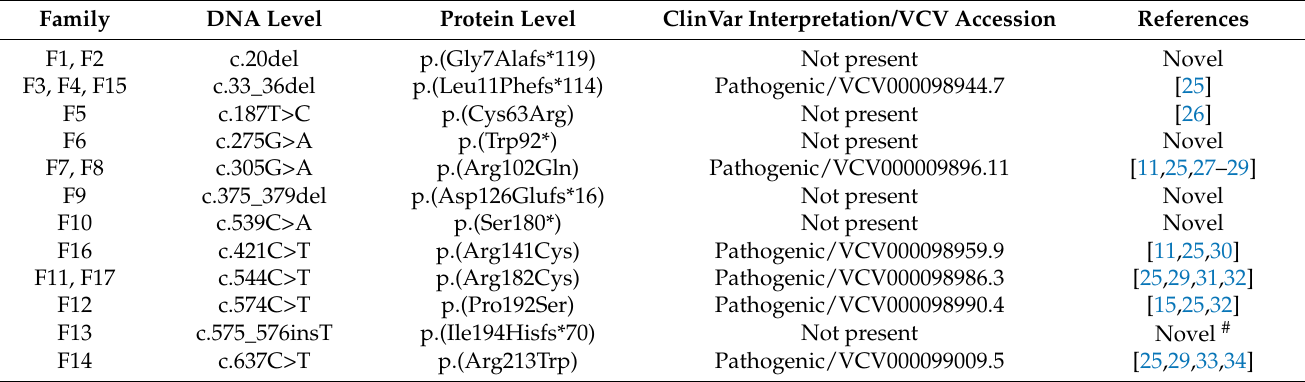
Table 1. RS1 disease-causing mutations identified in Czech families with X-linked retinoschisis.